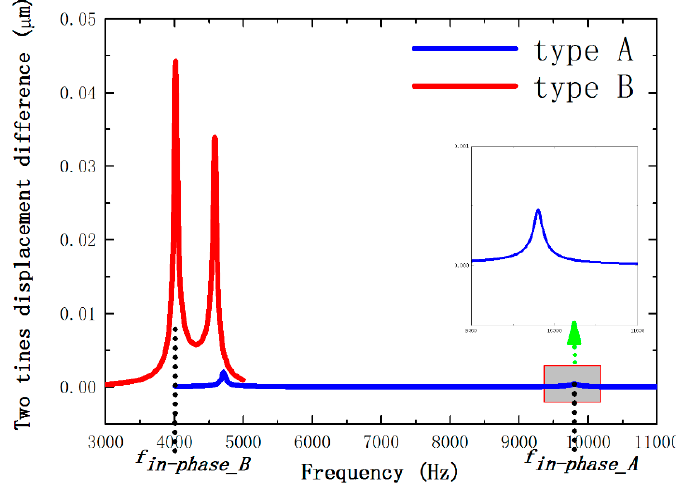
Figure 7. Displacement difference of 0.97% stiffness imbalance TFGs of two types.